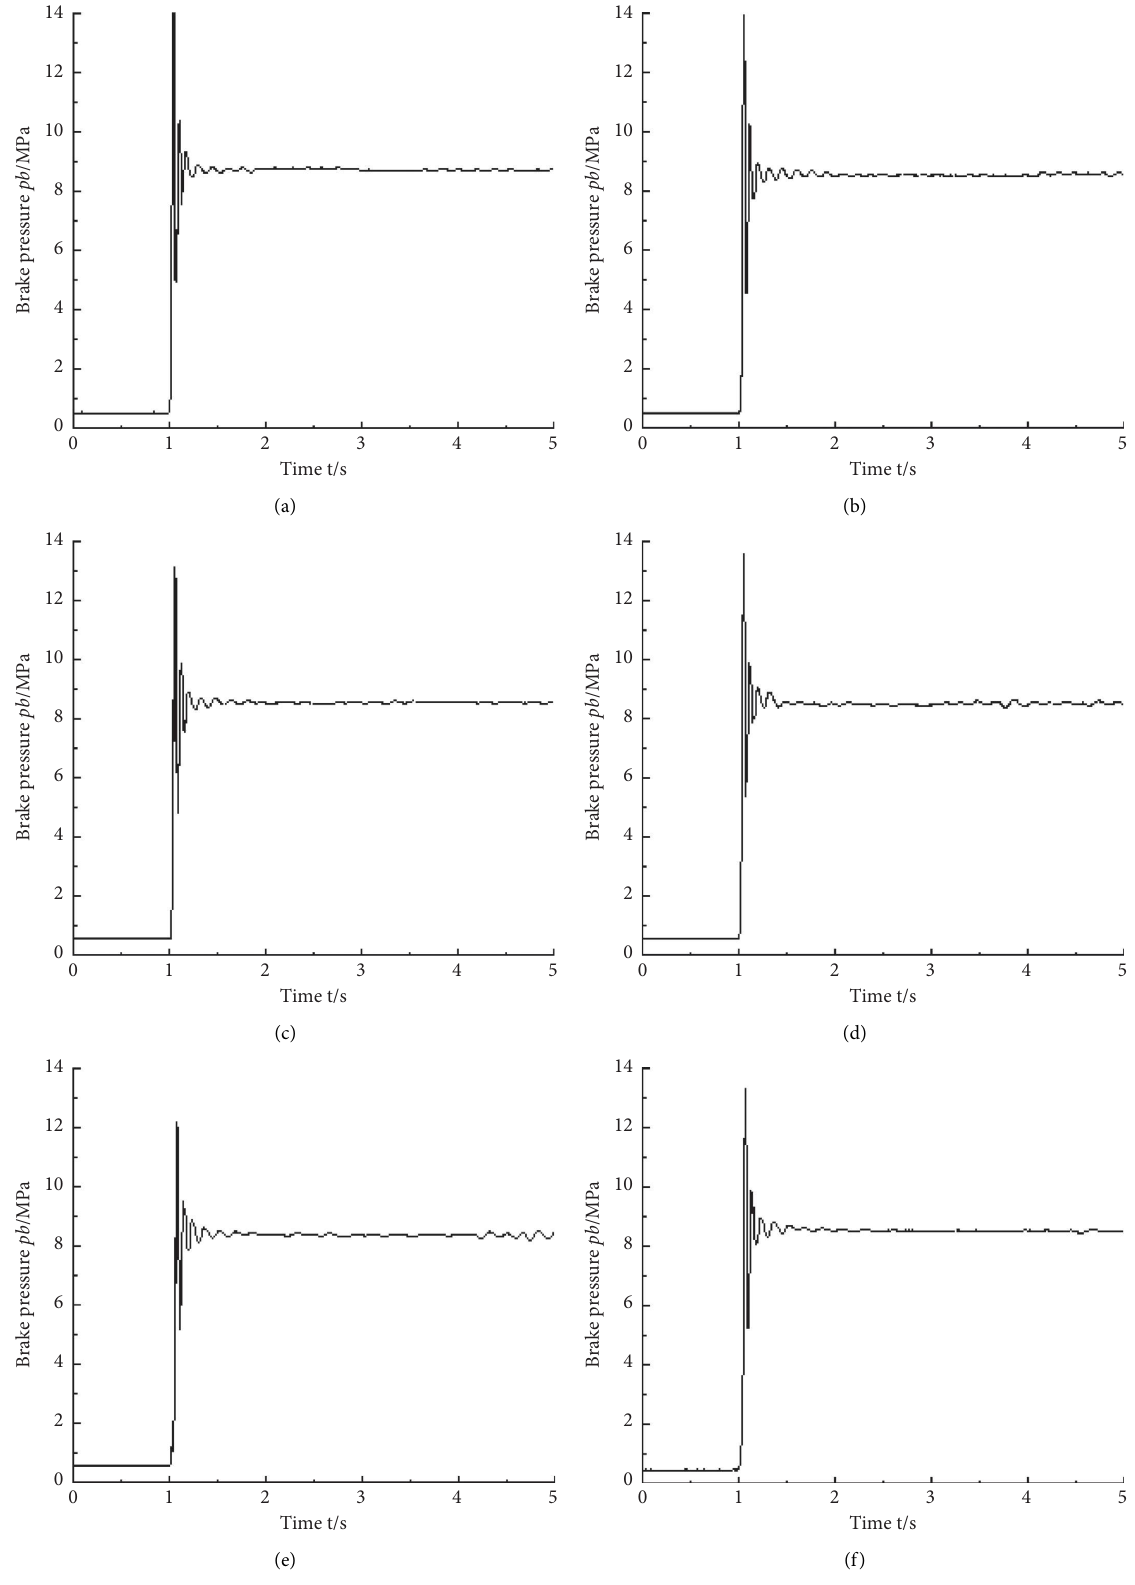
Figure 20: Pressure output of two-stage brake pressure servo valve-controlled cylinder system at 15MPa oil supply pressure. (a) 1-valve opening. (b) 2-valve opening. (c) 3-valve opening. (d) 4-valve opening. (e) 5-valve opening. (f) 6-valve